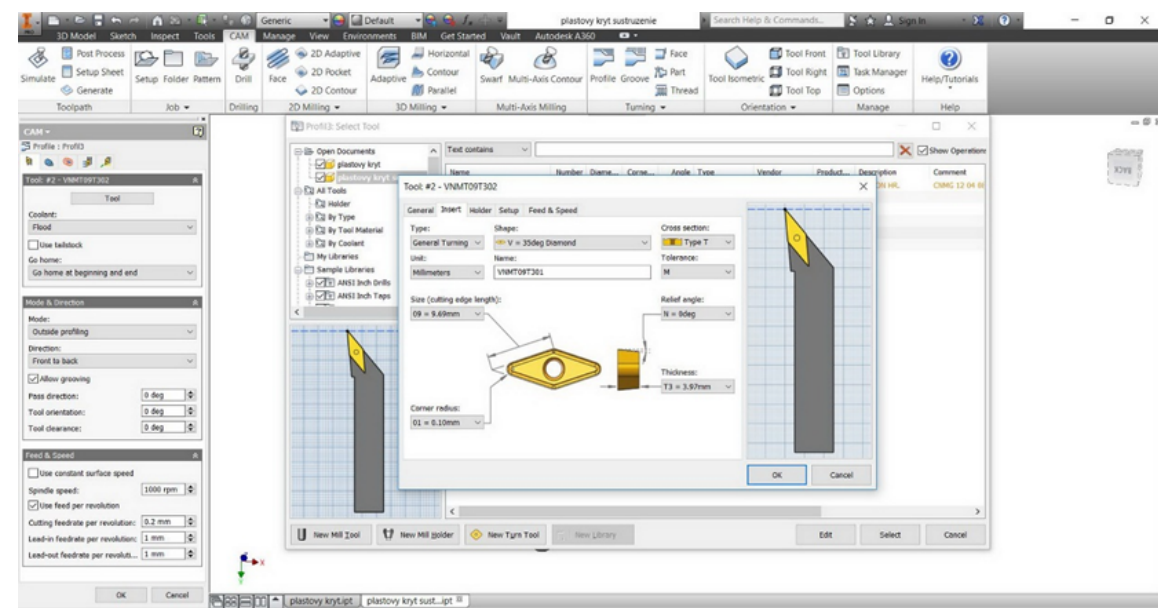
Figure 4: Choice of cutting tool and cutting conditions.